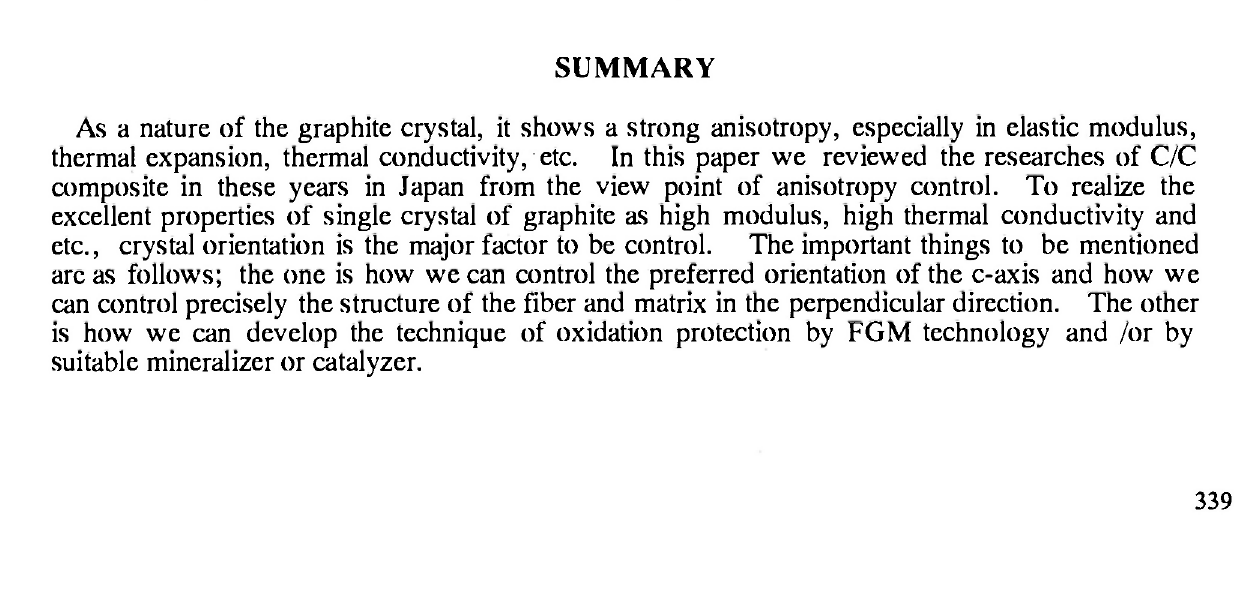
Fig. 11 Schematic diagram for SiC/C/Si /plymer process for oxidation